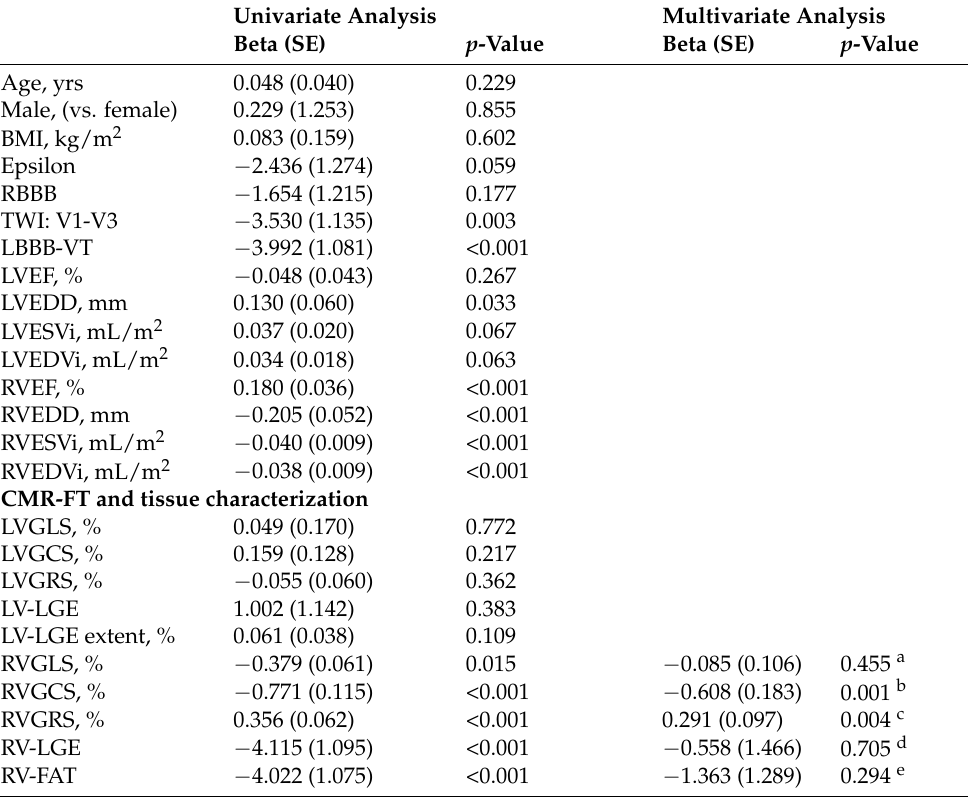
Table 3. Determinant factors of R wave amplitude after ICD implantation. Univariate